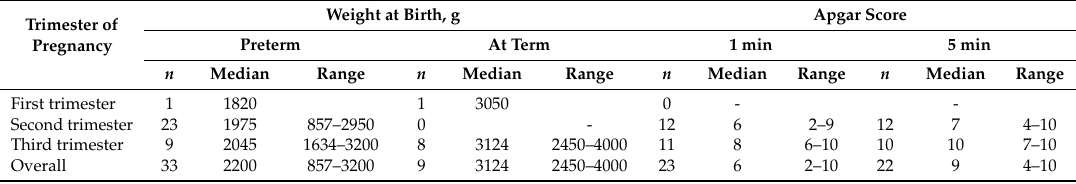
Table 5. Birth weight and Apgar score of infants by gestational age at diagnosis. Trimester of Pregnancy